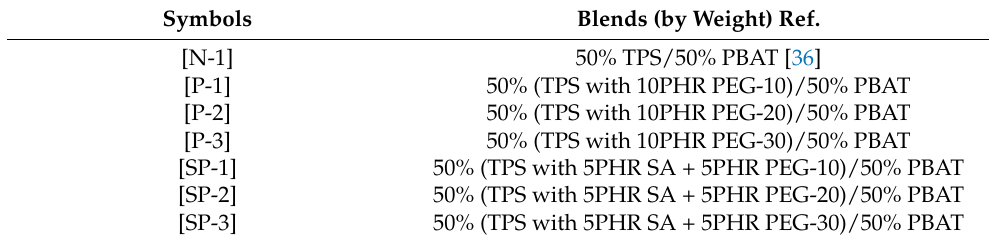
Table 1. The composite material composition ratio and corresponding symbols list. Symbols Blends (by Weight)